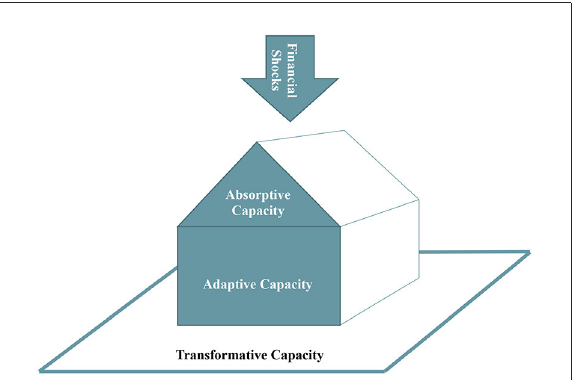
FIGURE1 The relationships between financial shocks absorptive, adaptive, and transformative capacity. At the top is a downward arrow representing financial shocks that a household may face (e.g., unexpected large medical bills, a car wreck damaging the family car, a main earner for the household losing their job) that may put the household in financial jeopardy and risk for food insecurity. For absorptive capacity, on-hand resources are used initially to buffer the shock (similar to how a roof protects a house). If the shock cannot be buffered, then the household must use adaptive capacity, such as skills, efficacy, knowledge, to react and adapt to the shock (represented in this model as the core of the house where the people live). If a household cannot react and adapt, they may be at risk for food insecurity. Transformative capacity refers to the conditional factors related to the community the household is situated in that limit or support a household’s ability to transform their resilience in the long-term (represented in the model as the area surrounding the